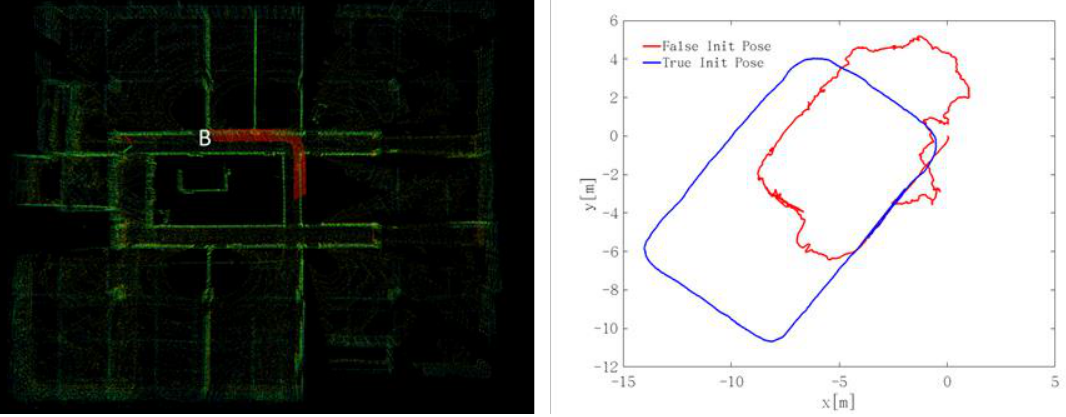
Figure 19. The influence of the initial true coordinate ( − 3.88, − 5.45, − 0.17) on the localization.